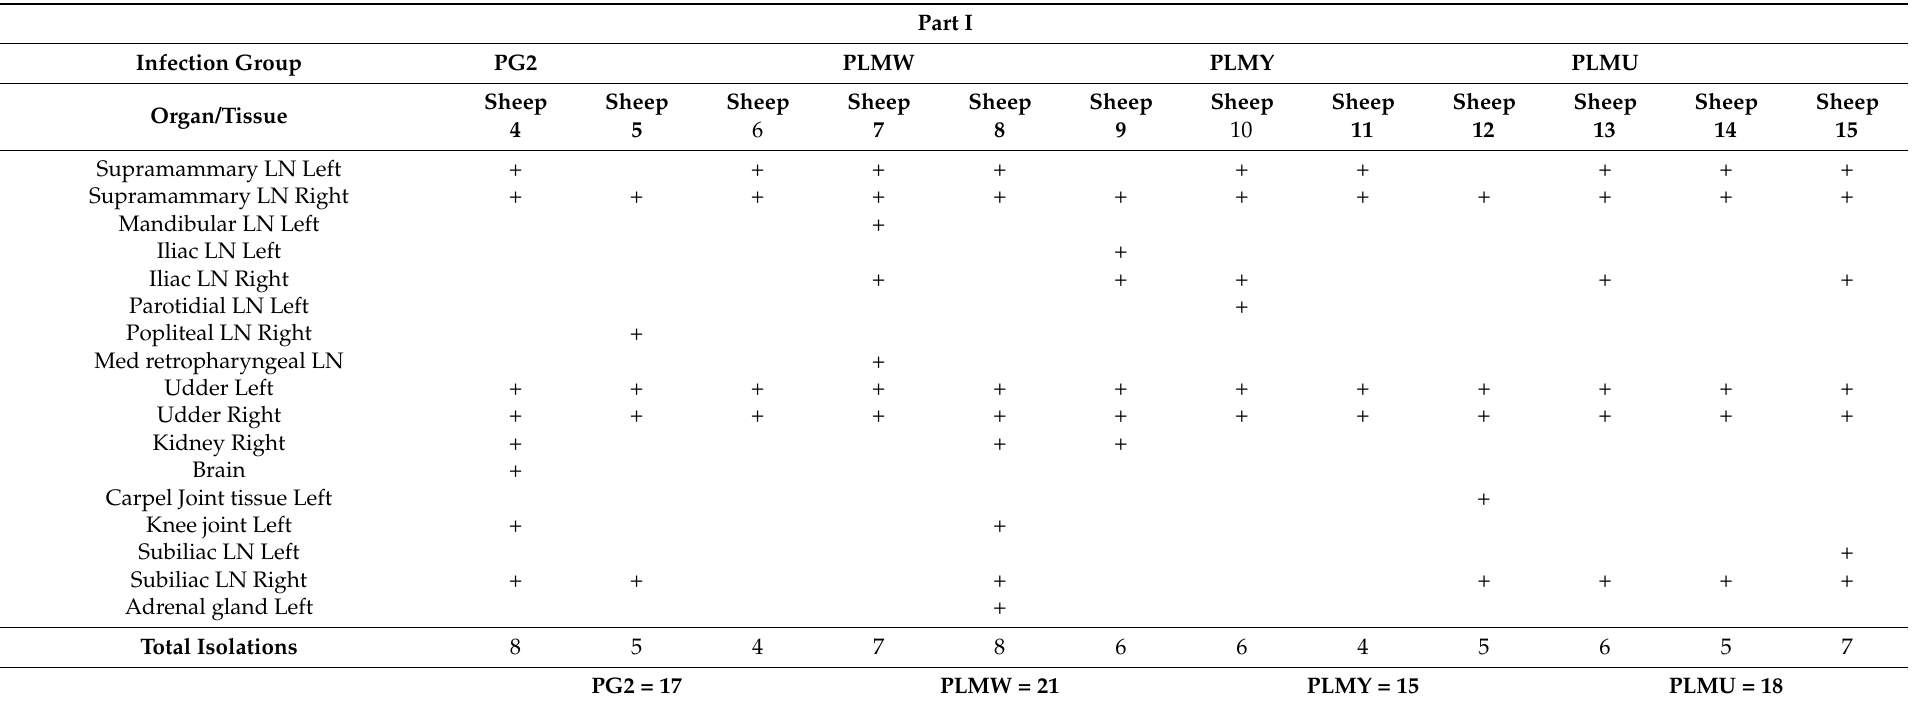
Table 6. Bacteriological examination of lymph nodes and organs from sheep inoculated by intramammary route with 10 9 viable cfu of M. agalactiae wild type strain (PG2) or Vpma phase locked mutants (PLMs) and necropsied at Day 15–18